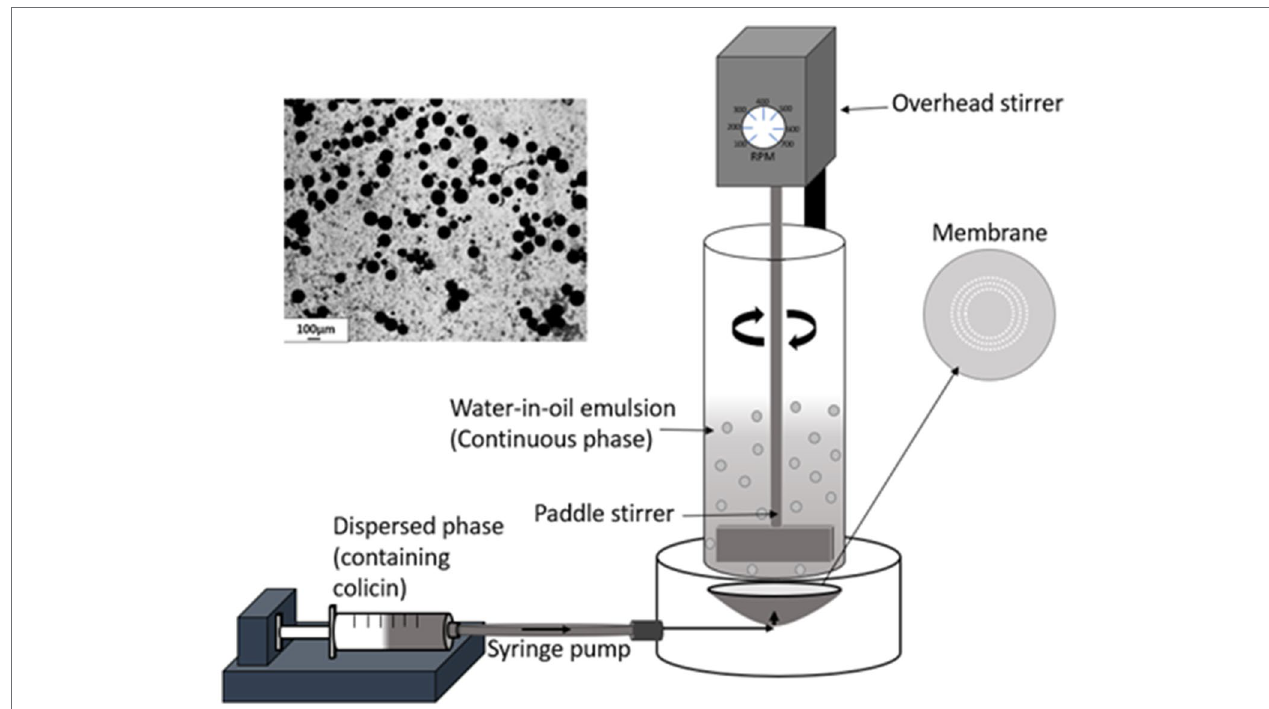
FIGURE 1 | Schematic representation of the membrane emulsification process. The aqueous phase containing the dissolved colicins in the polymer formulation was pumped through a microporous membrane. The stainless-steel membrane had 40 μ m uniform circular pores arranged in a ring format located at an optimal radial position where the rotating paddle stirrer provides maximum surface shear for aqueous droplet detachment. At low liquid flow rates, interfacial forces dominate, the drop grows before finally detaching from the membrane surface due to the surface shear caused by the dispersed phase flowing across the membrane surface and the droplets are carried away into the bulk continuous oil phase. The image (top left) shows the prepared microcapsules after exposure to TSA and alginate